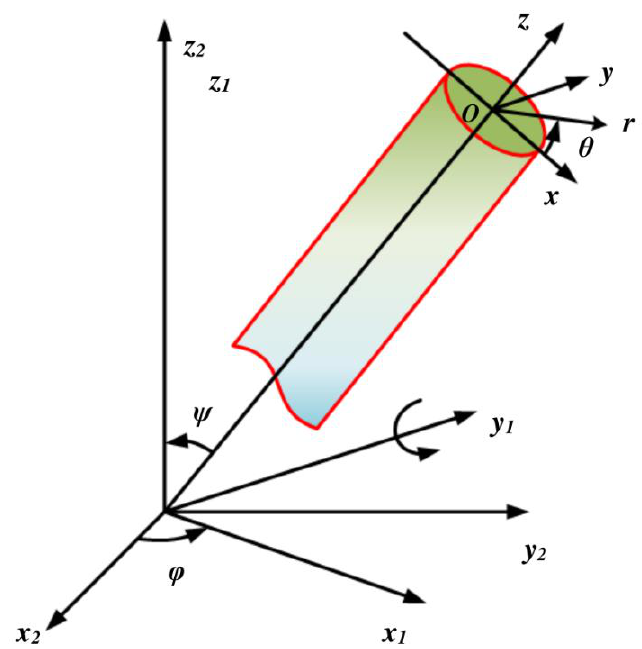
Figure 2. Coordinate transformation diagram of a deviated well axis.